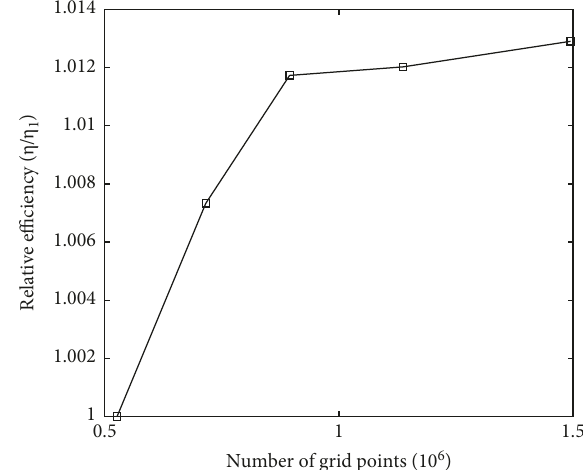
Figure 15: Grid sensitivity of the IETsupercritical CO 2